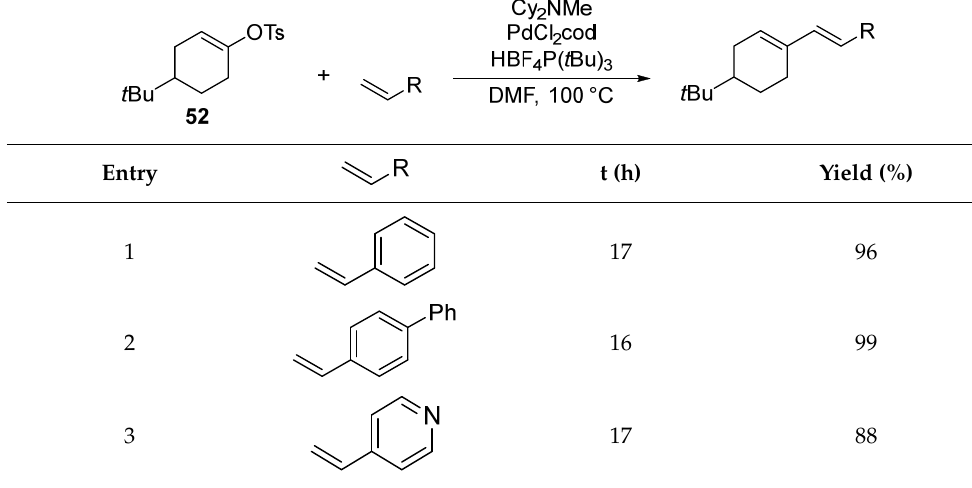
Table 12. Generalization of the method by Skrydstrup’s group.